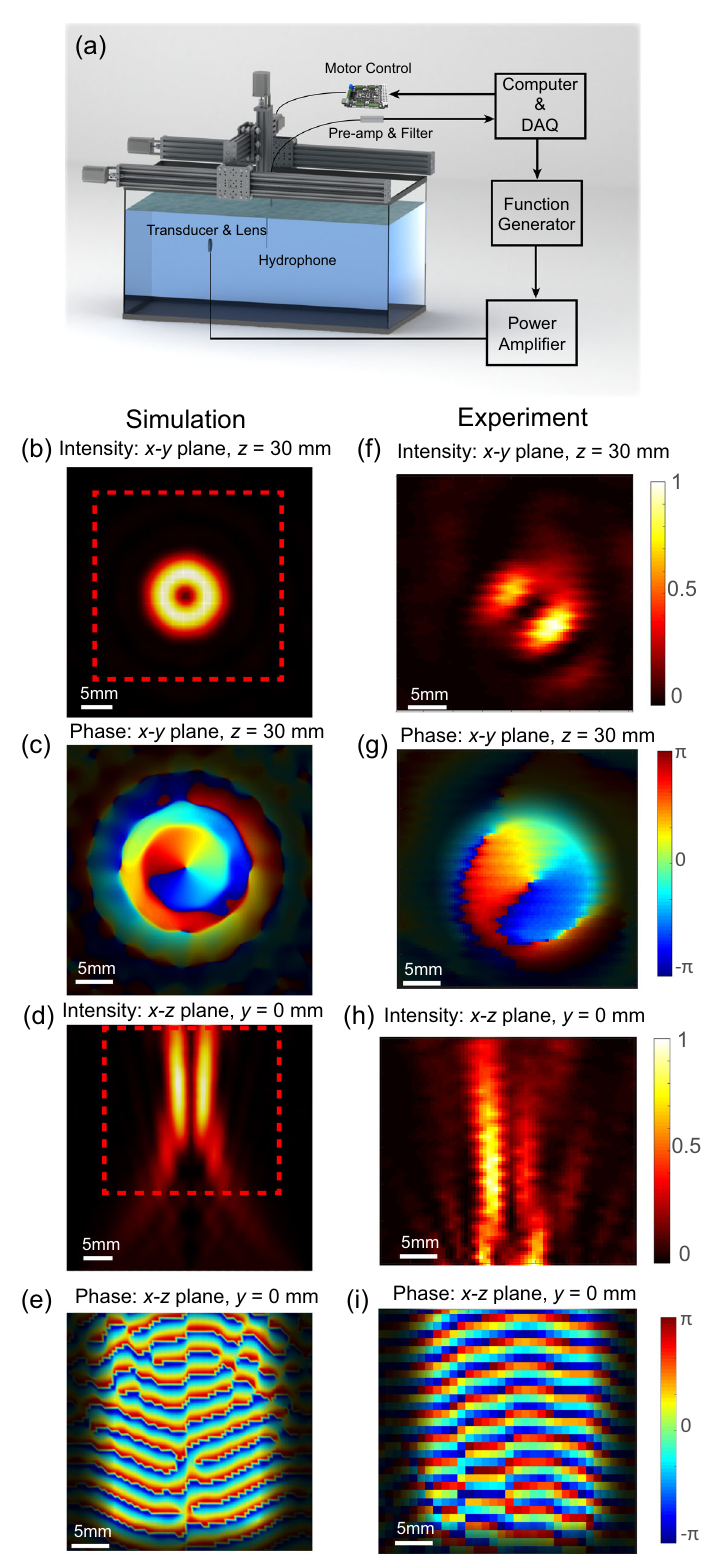
Fig. 2 Measurement of the acoustic fi eld. a Illustration of the ultrasound scanning system. b , c Simulated intensity and phase fi eld of the x – y plane at z = 30 mm. The ring-shaped intensity pro fi le provides the 2D trap. The spiral phase pro fi le is clearly seen in the central region. d , e Simulated intensity and phase fi eld of x – z plane at y = 0. The intensity forms a node line along z axis, along which the phase is discontinuous. f – i The corresponding measured intensity and phase fi eld in the experiment, in fair agreement with the